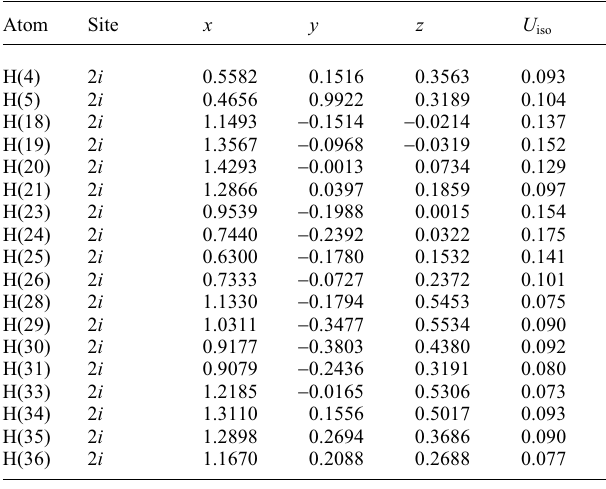
Table 2. Atomic coordinates and displacement parameters (in Å 2 )